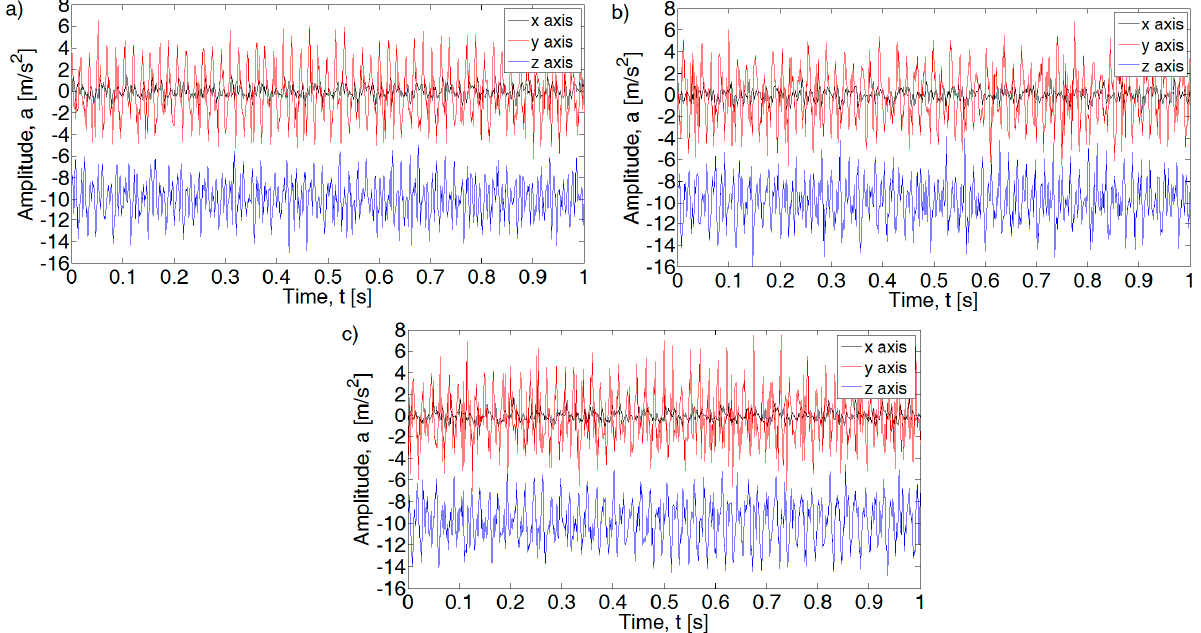
Sensors 2021 , 21 , x FOR PEER REVIEW 8 of 19 Figure 4. Exampleofaccelerationsensorsignalfor1250rpm: ( a )efficientengine, ( b )pressureinefficient, and( c )injectioninefficient. Figure 4. Example of acceleration sensor signal for 1250 rpm: ( a ) efficient engine, ( b ) pressure inefficient, and ( c ) injection inefficient .